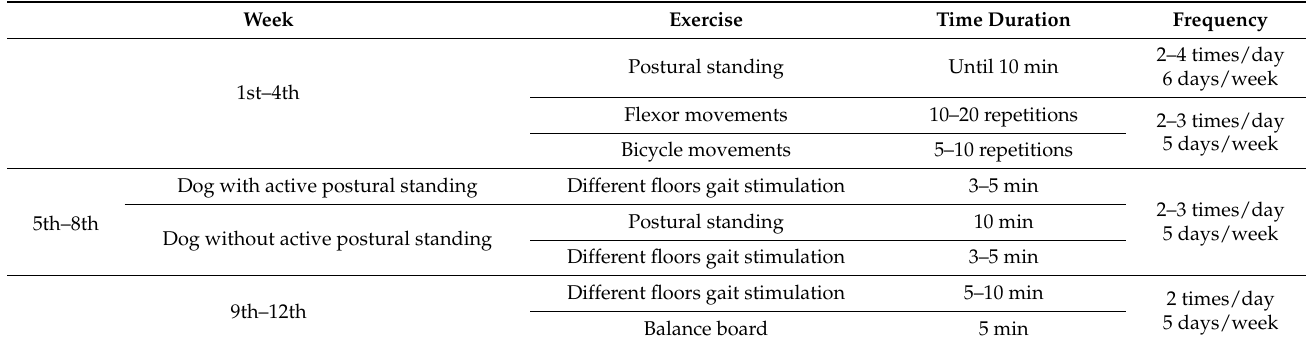
Table 4. Kinesiotherapy exercise training.